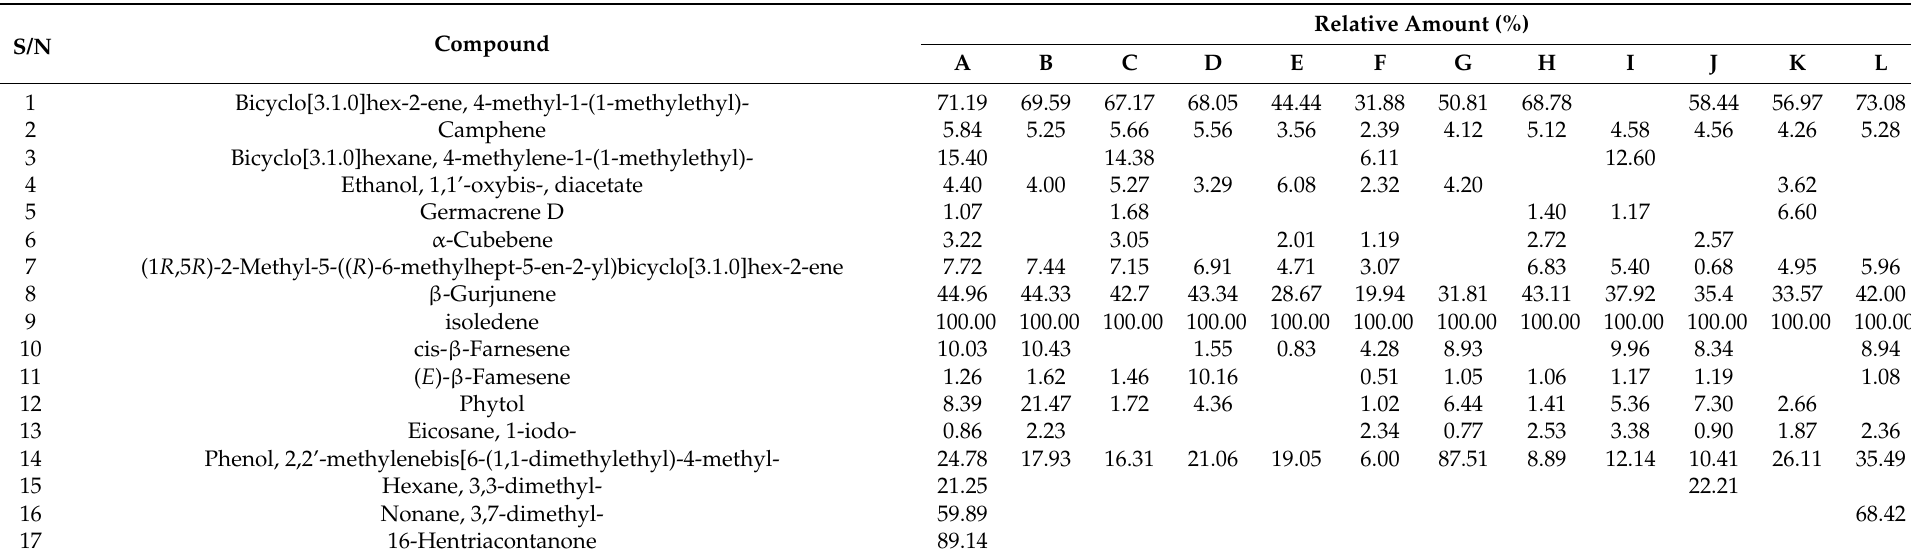
Table 5. Chemical compositions of the petroleum ether extractives of Alnus cremastogyne